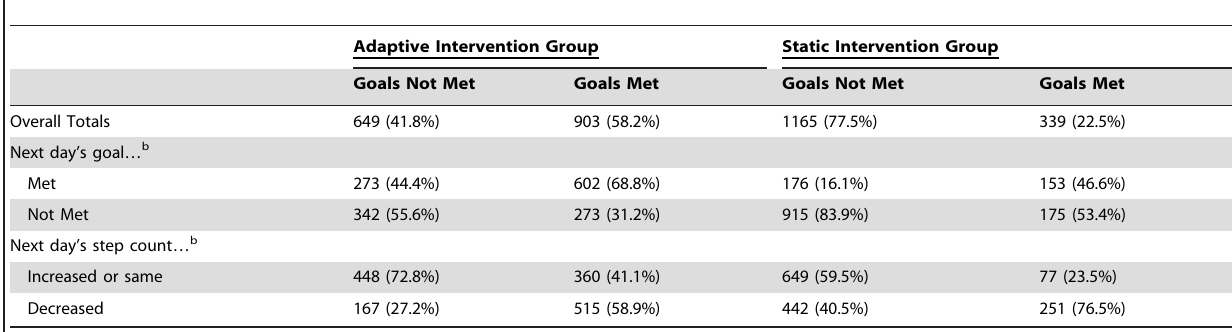
Table 3. Goal Attainment and its Effect on Future Behavior by Group Status. a